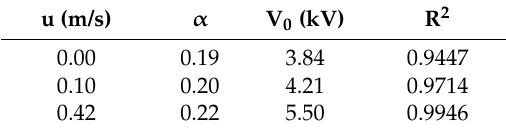
Table 8. Values of the fitted parameters from Equation (7).